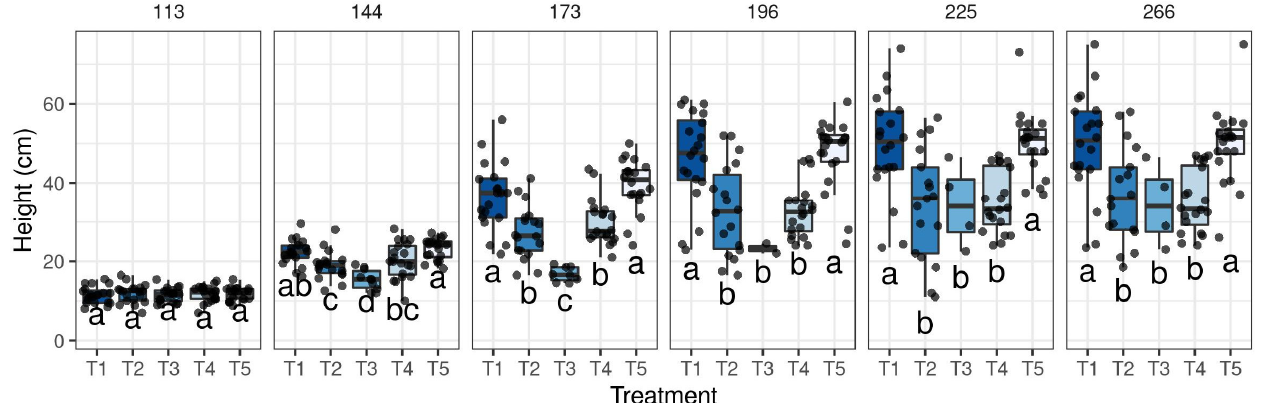
Figure 4. Boxplot of hazelnut Tonda Gentile plant height depending on substrate and DOY. T1 = Commercial Peat (P) 90% + Compost B(CB) 10%; T2 = P 80% + CB 20%; T3 = P 60% + CB 40%; T4 = Commercial Peat (P) 100%; T5 = P Commercial Peat 100% + Osmocote. Different letters indicate statistically significant differences after ANOVA and Duncan post-hoc test at p -value < 0.05. Individuals lost during the trial were removed from the